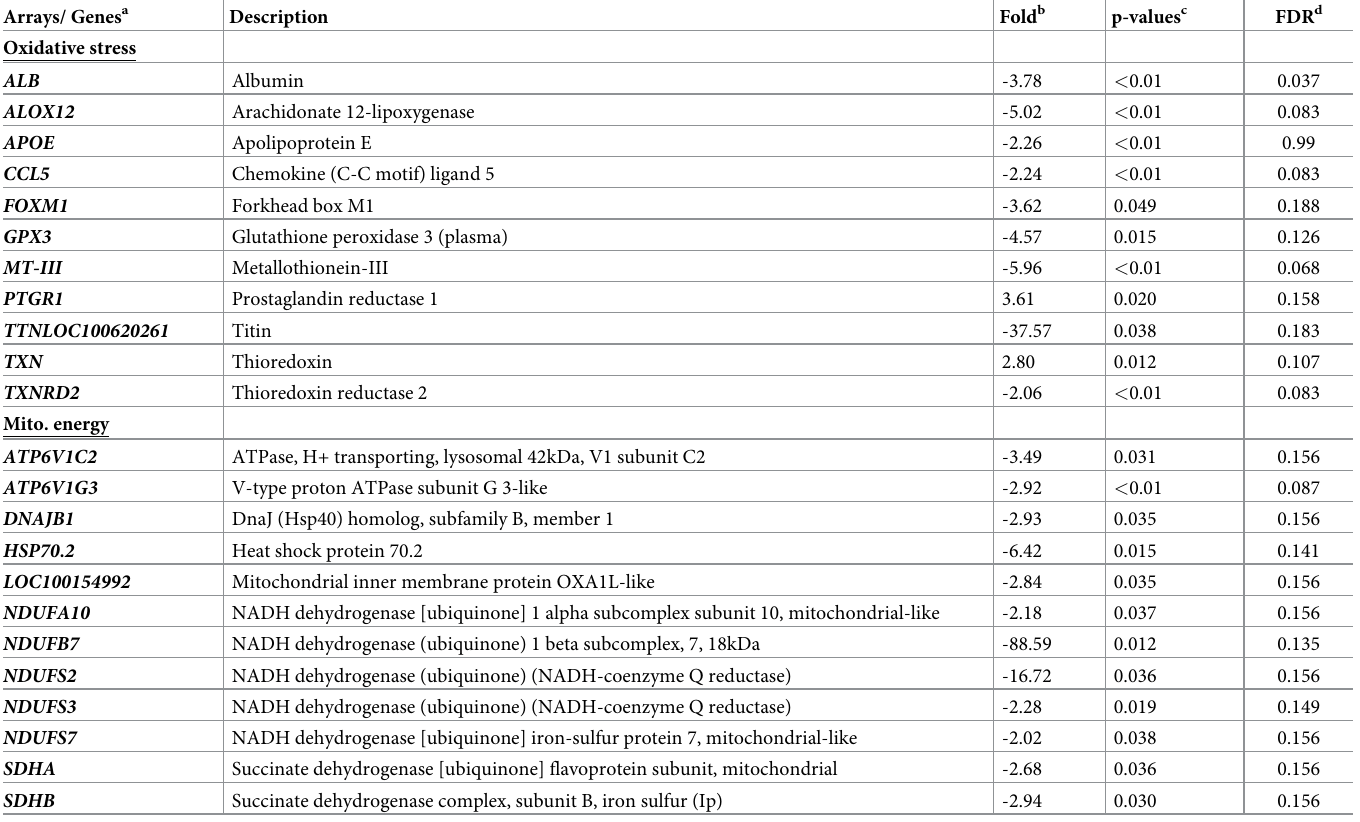
a RT 2 -profilers used were oxidative stress and mitochondrial energy metabolism (mito. energy) and each array included 84 genes. b Fold change (2 - ΔΔ Ct ) is the normalized gene expression (2 - Δ Ct )) at d 23 divided the normalized gene expression (2 - Δ Ct ) at d 14. Fold-change values greater than one indicates a positive- or an up-regulation and values less than one indicate a negative or down-regulation. c The p values are calculated based on a Student’s t-test of the replicate (2 - Δ Ct ) values for each gene from NBW piglets of both ages. d The FDR is the False Discovery Rate adjusted